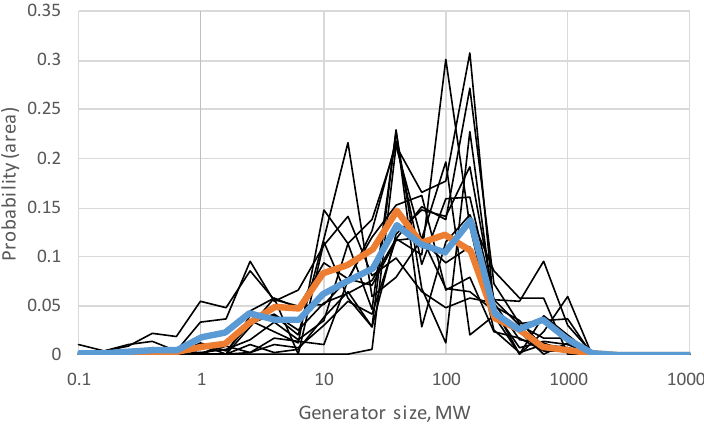
Figure 3. Probability density of generator capacity, with height representing area since it is a logarithmic plot, for EI (blue), WECC (orange), and 12 subset cases (black).